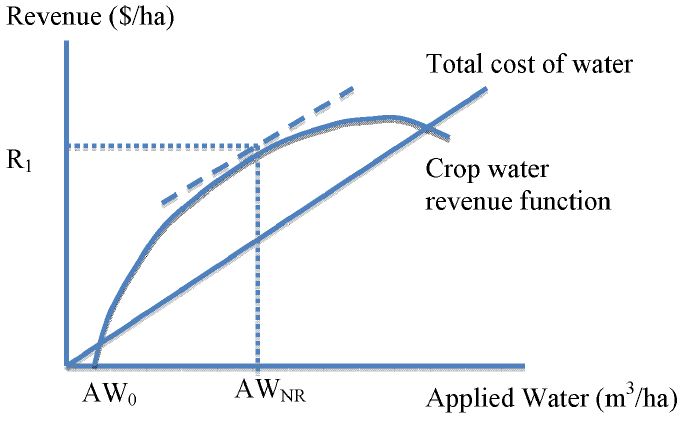
Figure 3. Depicting the profit-maximizing amount of applied